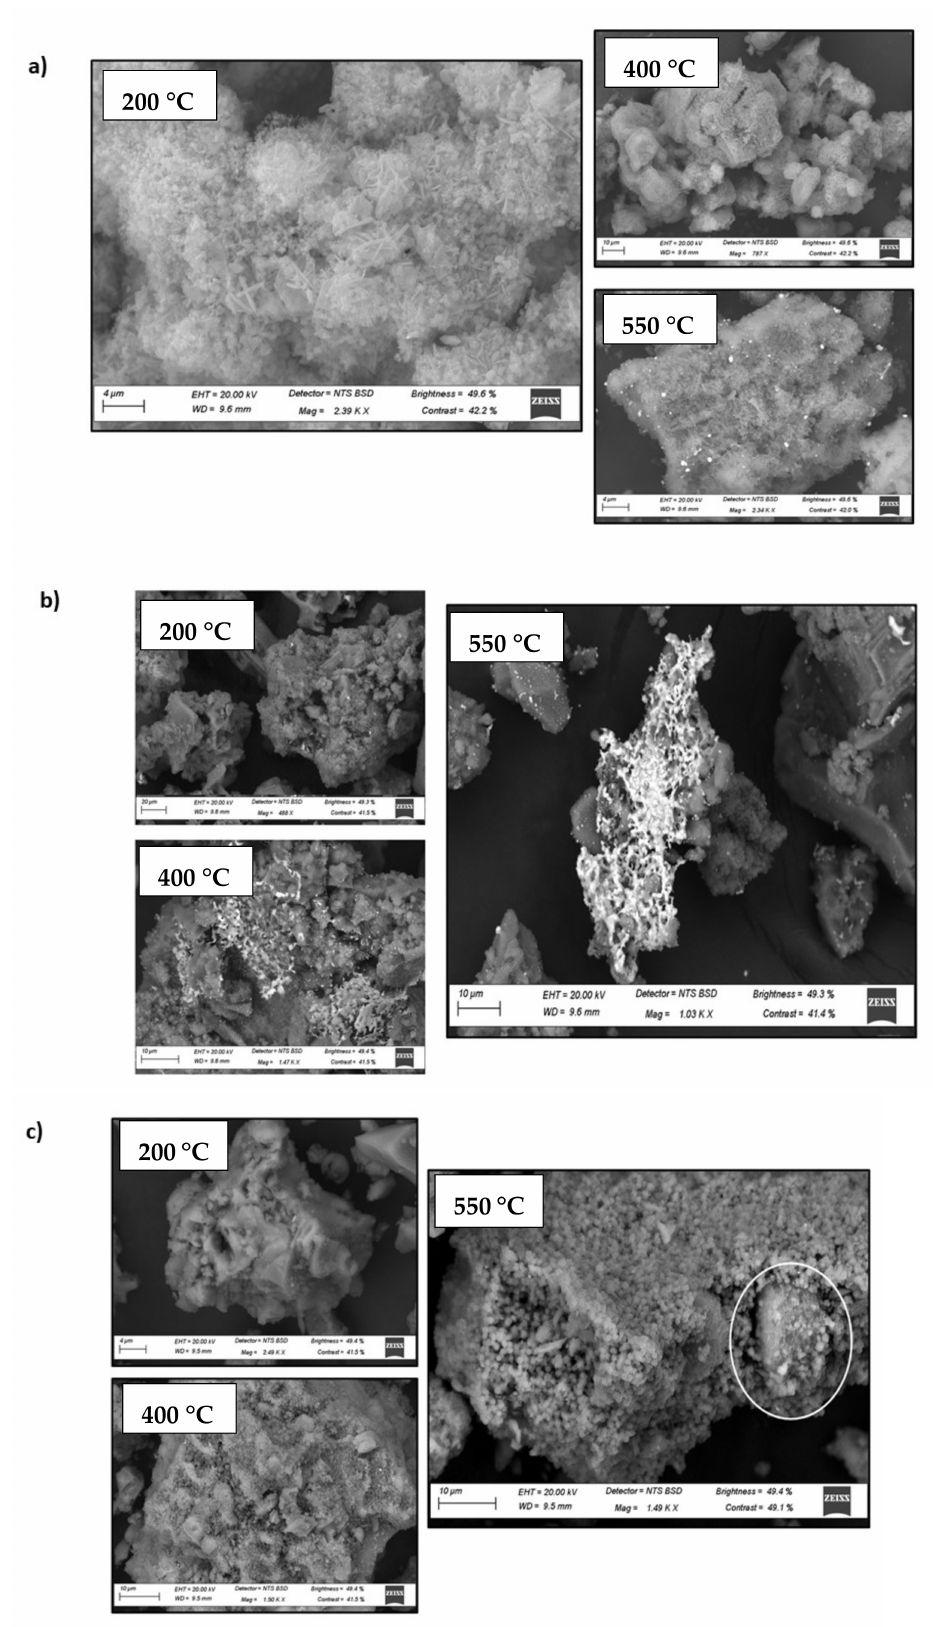
Figure 3. SEM images of Ni/MgAl 2 O 4 sulfided with ( a ) (NH 4 ) 2 SO 4 ( b ) (NH 4 ) 2 S and ( c ) DMSO at 200 ◦ C, 400 ◦ C, and 550 ◦